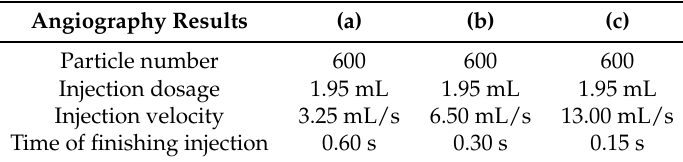
Table 2. Injection conditions with various injection velocities.